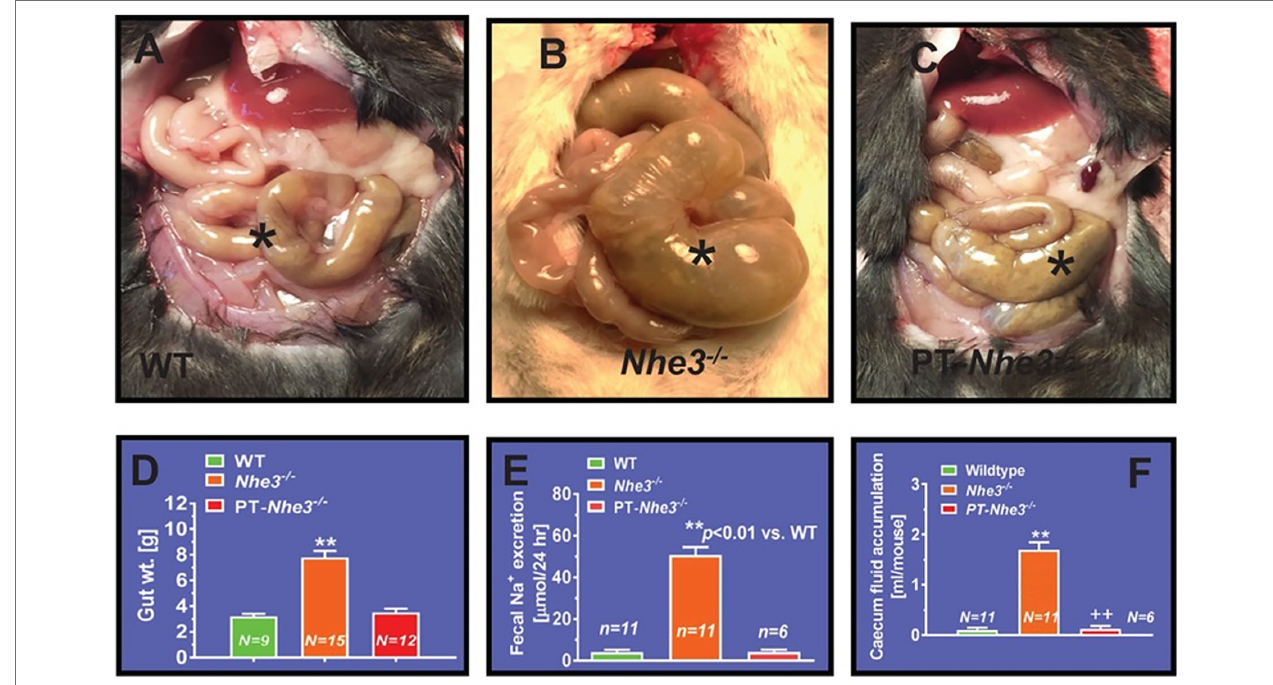
FIGURE 2 | Proximal tubule-specific deletion of NHE3 does not significantly alter the intestinal structural and absorptive phenotypes in PT- Nhe3 − / − mice. (A) A representative normal caecum segment between small and large intestines in a WT mouse (*). (B) A representative cecum segment between small and large intestines in a global Nhe3 − / − mouse, showing the extremely enlarged cecum segment accumulated with a large volume of fluid content inside (*). (C) A representative cecum segment between small and large intestines in a PT- Nhe3 − / − mouse, showing the lack of enlarged cecum segment and no accumulation of a large volume of fluid content in the cecum segment (*). (D) The overall gut weight more than doubled in global Nhe3 − / − mice than WT and PT- Nhe3 − / − mice ( p < 0.01). (E) Twenty-four hours fecal Na + excretion was ~10-time higher in global Nhe3 − / − mice than WT and PT- Nhe3 − / − mice ( p < 0.01). (F) Accumulation of fluid content in the cecum segment was ~10 times higher in global Nhe3 − / − mice than WT and PT- Nhe3 − / − mice ( p < 0.01). There were no differences in the overall gut weight and 24 h fecal Na + excretion between WT and PT- Nhe3 − / − mice. Reproduced from Li et al., 2018 with permission from the copyright